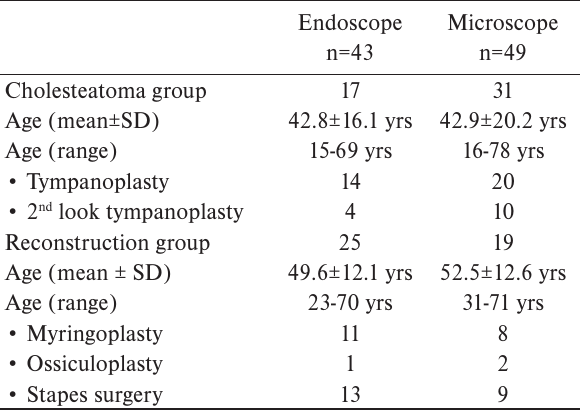
Table 1. Patient characteristics and types of procedures in each particular